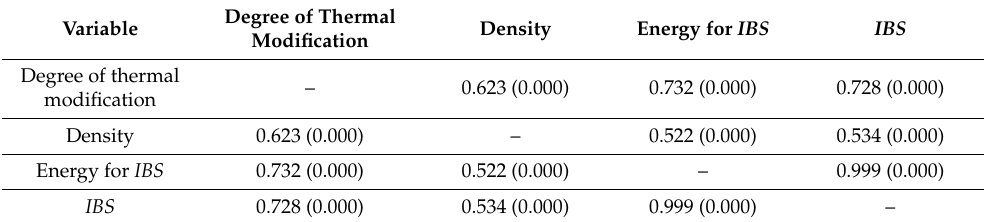
Table 3. Absolute correlations and their p -values for dynamic bending.